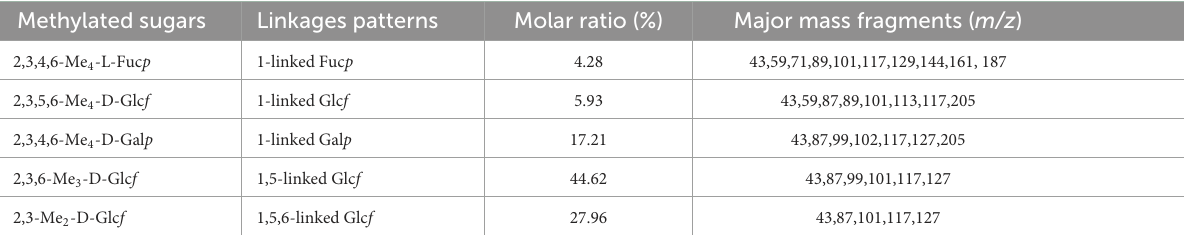
TABLE 1 Linkage patterns of SVPS2 by methylation and GC-MS. Methylated